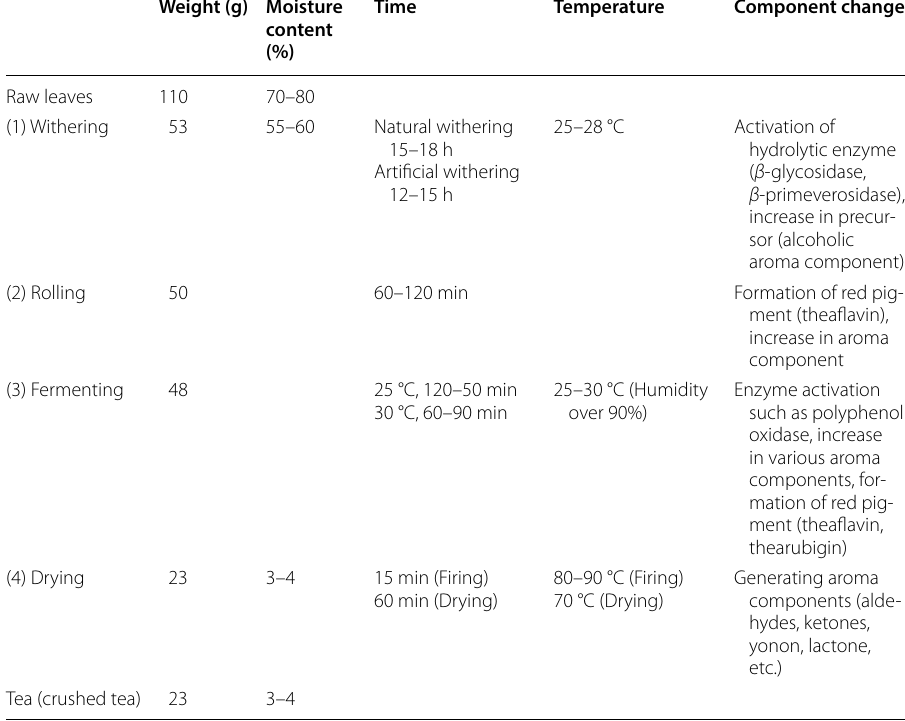
Table 2 Manufacturing process of tea (Yamanishi 1992; Omori et al.